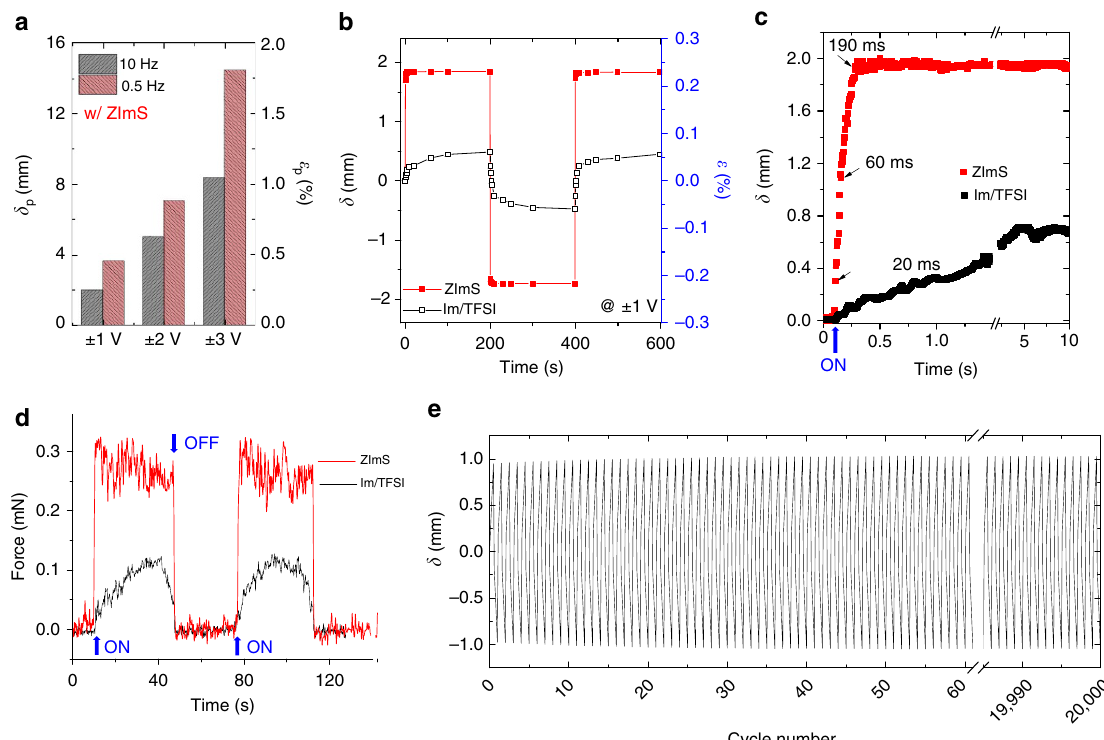
Figure 3 | Low-voltage-driven superfast actuators. ( a ) Peak-to-peak displacement ( d p ) and bending strain ( e p ) of the actuator containing ZImS at voltages of ± 1, ± 2 and ± 3V and frequencies of 0.5 and 10Hz. ( b ) The d and e values of the actuator containing ZImS at alternating square-wave voltages of ± 1V, in comparison with the actuator containing Im/TFSI. ( c ) Laser-displacement measurements and ( d ) the force generation of the actuator with ZImS, compared with that containing Im/TFSI, by applying 1V. ( e ) Cycle life of the actuator under continuous operation in air at ± 1V and